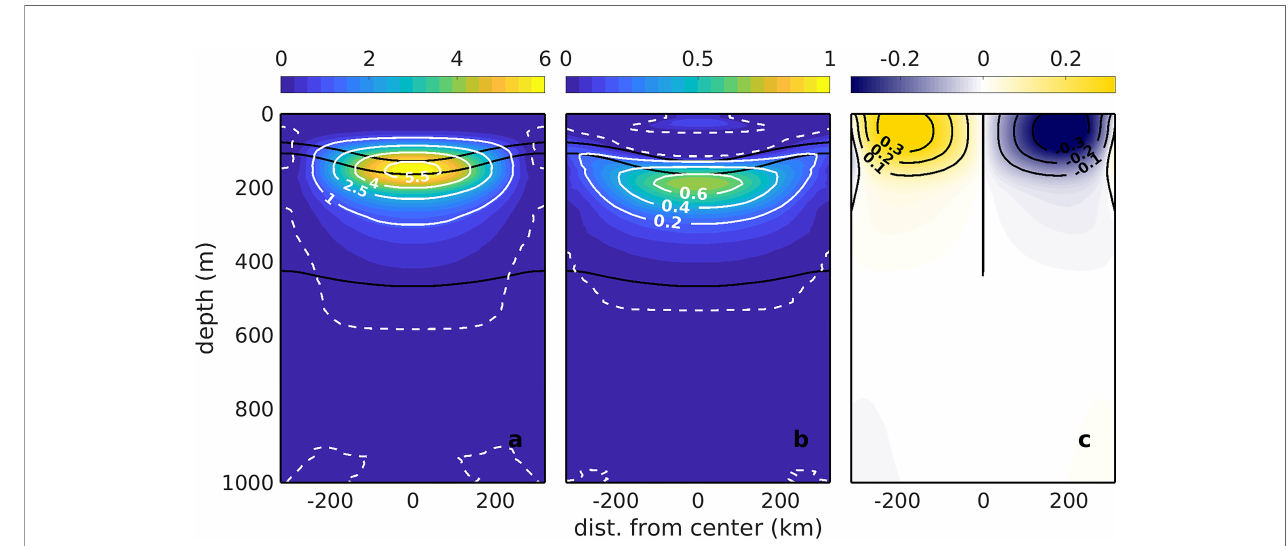
FIGURE 6 | Vertical sections across the mean NBC ring. In (A, B) the T and S anomalies, respectively, calculated by subtracting the T and S of all IR pro fi les from the mean T and S of all OR pro fi les. The white dashed lines represent the zero anomaly isolines, and the black lines are (from top to bottom) the 24.5, 25.5 and 27.1 kgm - ³ isopycnals. In (C) the anticyclonic geostrophic velocities (in ms -1 ) of the mean NBC ring, referred to 500db and computed for the Coriolis parameter corresponding to a mean latitude of